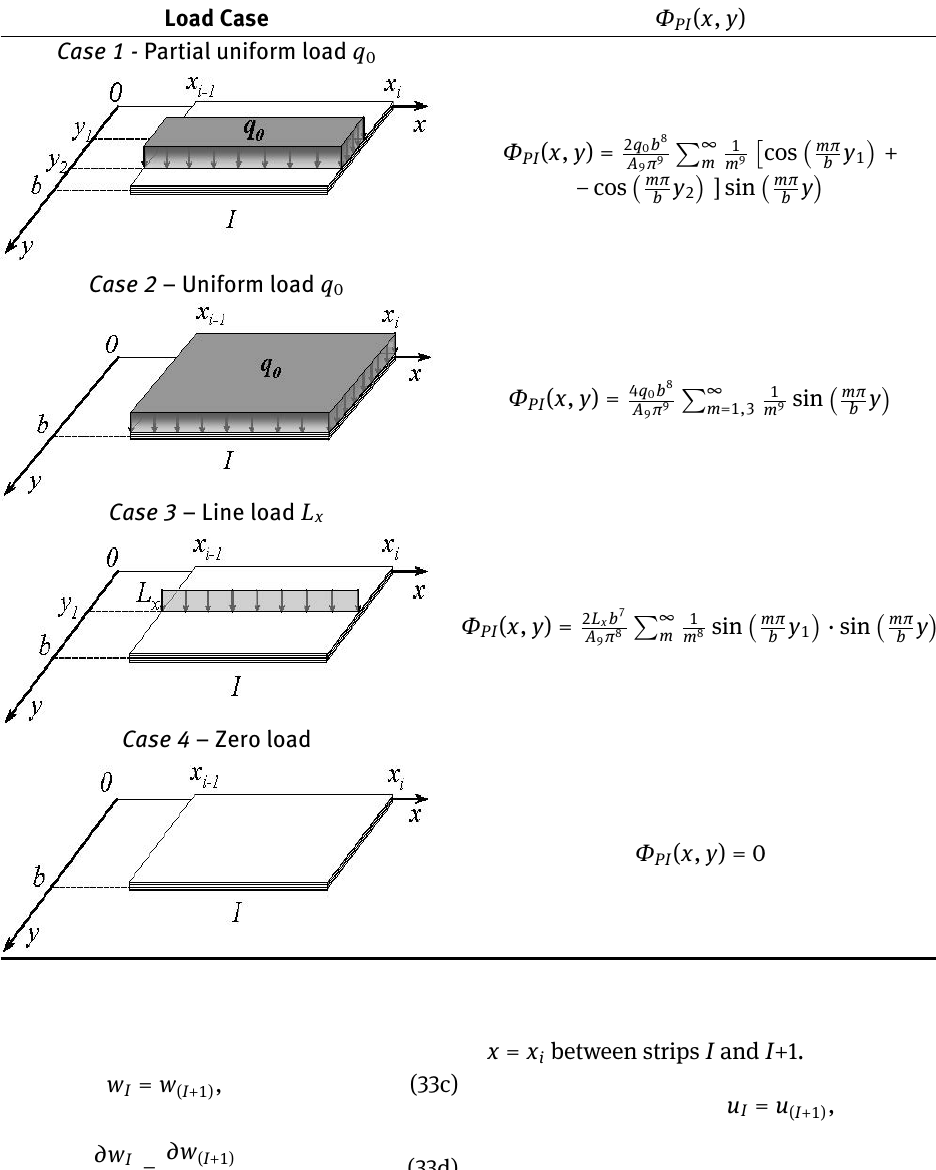
Table 1: Particular solution Φ PI ( x , y ) for a laminated plate strip I